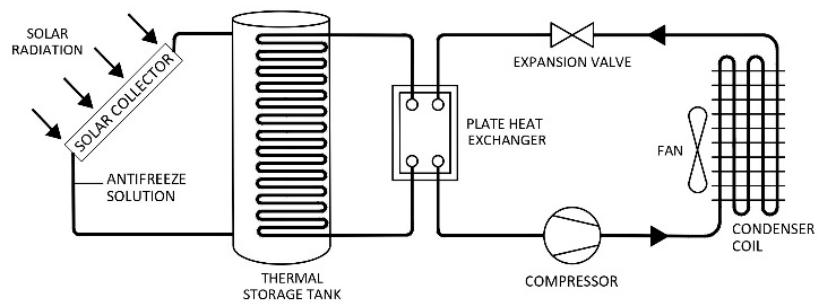
Figure 13. The schematic of the series IX-SAHP system.